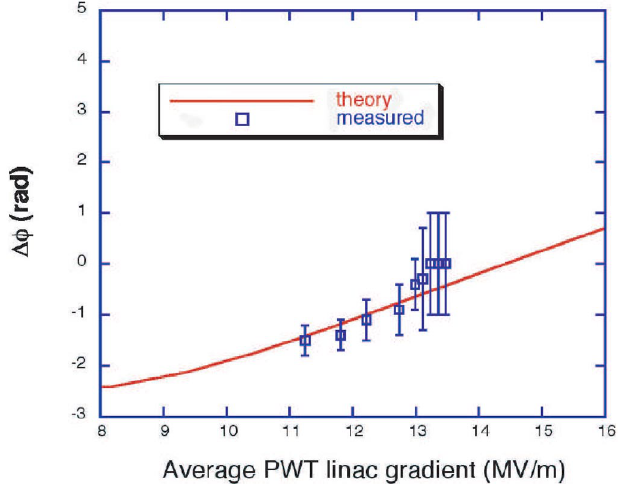
FIG. 10. (Color) Maximum bunching phase in PWT versus PWT accelerating gradient, theory and measurement.